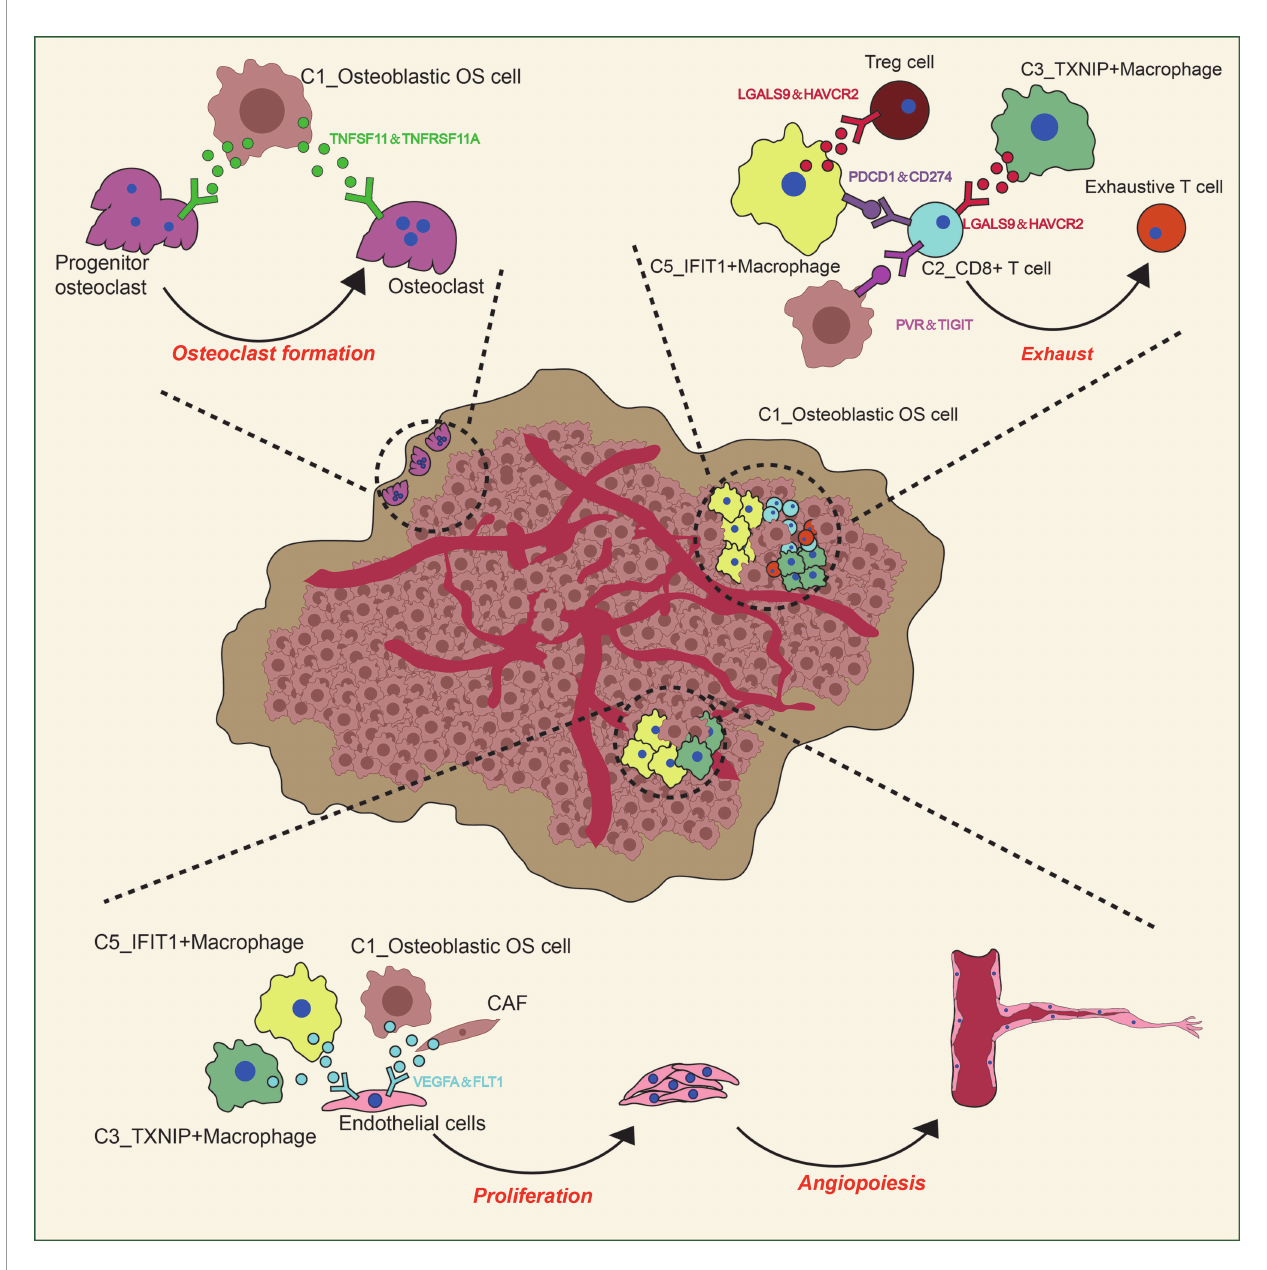
FIGURE 10 | Predicted regulatory network, centered on